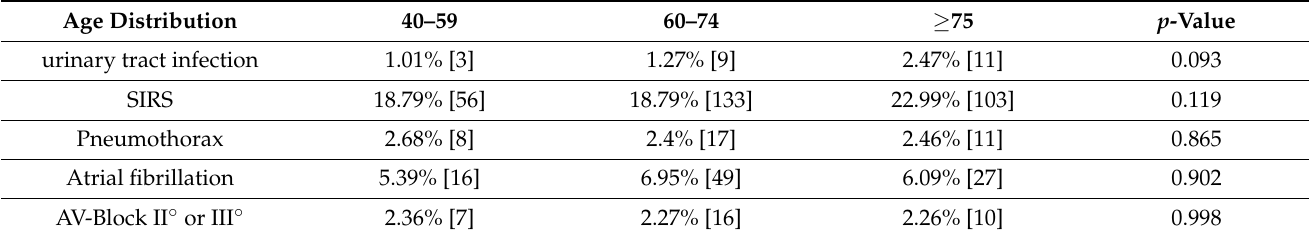
The subgroup analysis of elderly patients showed very similar results. Thus, not only mortality was significantly higher with increasing age ( p < 0.001), but also postopera- tive kidney failure ( p = 0.009), postoperative pleural effusion ( p = 0.006), and respiratory insufficiency ( p = 0.009). Chronic renal insufficiency could be observed as a preoperative comorbidity with increasing age ( p = 0.034). Furthermore, a trend towards more female patients ( p = 0.017) and lower BMI (0.05) was found with increasing age (Table